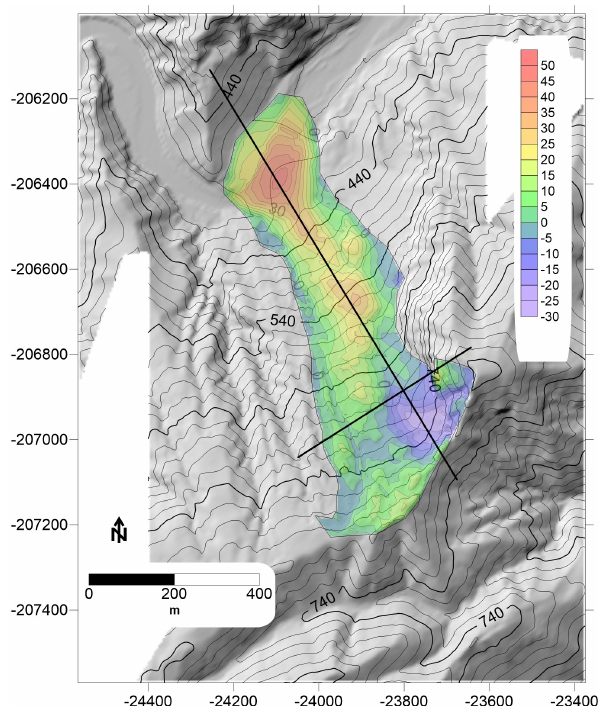
Figure 22. Map of the thickness (in metres) of the reconstructed deposit of the Akatani-east landslide based on the inverse SLBL ( C = 0 . 015), which was subtracted from the mixed scenario result. The background is the post-DEM hillshade and includes the recon- struction of the lower part of the deposit.